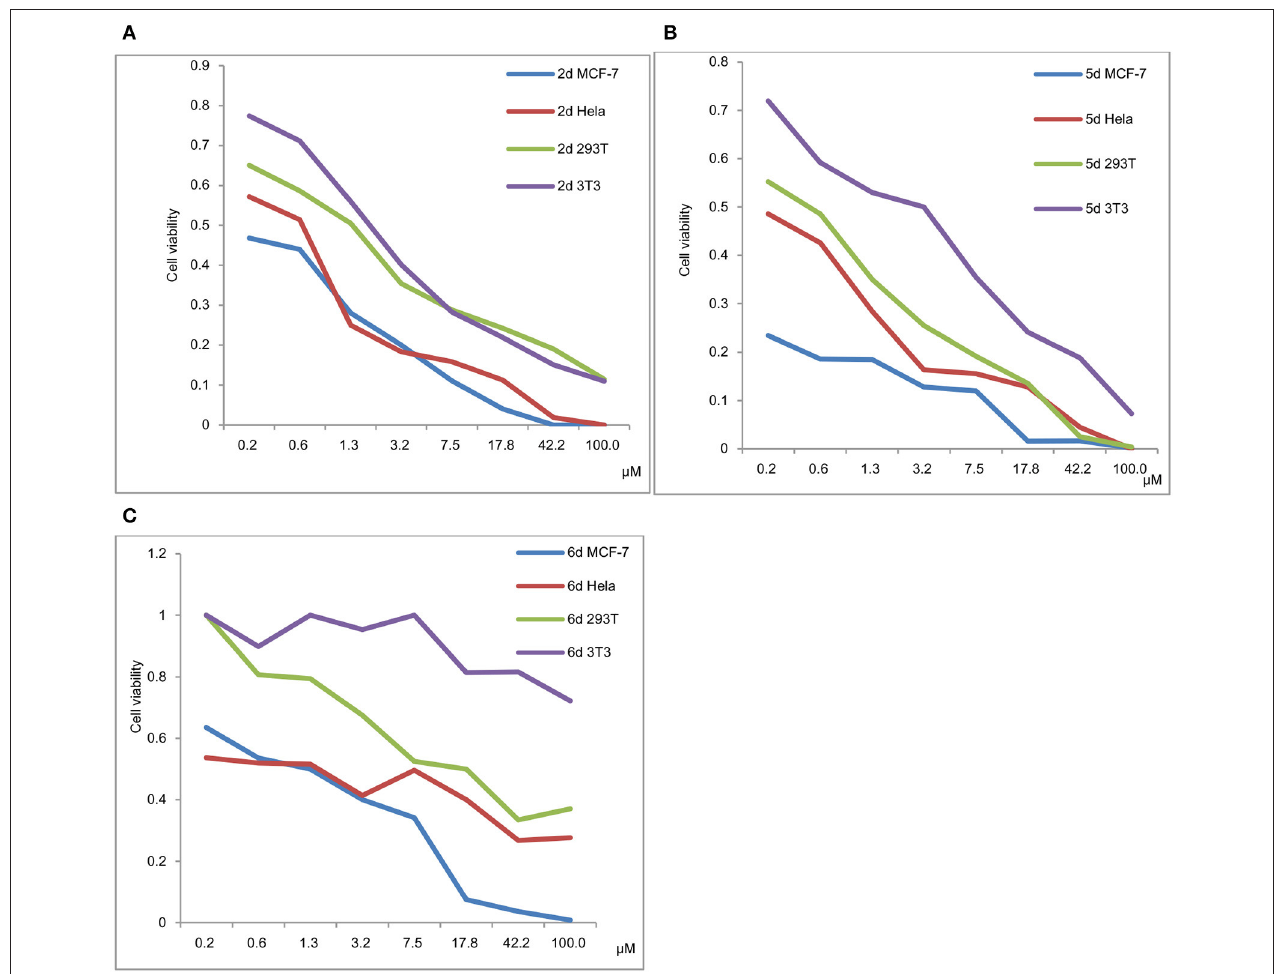
FIGURE 4 | (A) Viability of MCF-7, HeLa, 293T and 3T3 in a 48h incubation assay ( 2d ). (B) Viability of MCF-7, HeLa, 293T and 3T3 in a 48h incubation assay ( 5d ). (C) Viability of MCF-7, HeLa, 293T and 3T3 in a 48h incubation assay ( 6d